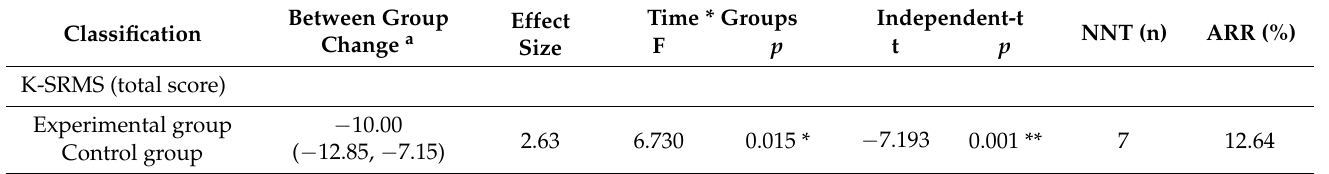
Table 8. Changes in rehabilitation motivation between intervention on two intervention groups.